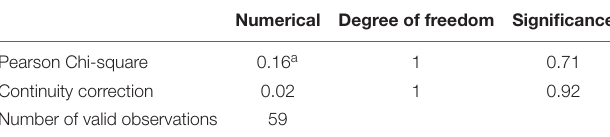
TABLE 4 | Gender test summary